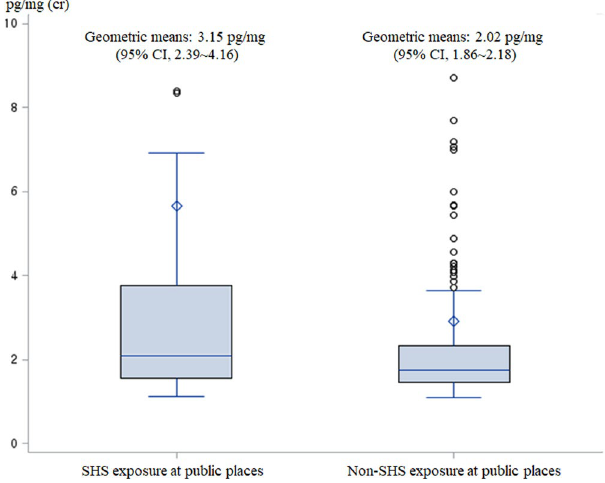
Appendix figure. Children’s urinary NNAL concentration according to SHS exposure in public places. And the result of the t-test on the log-transformed data ( T value = 0.270, P value = 0.05). Age, sex, and parental smoking patterns at home were